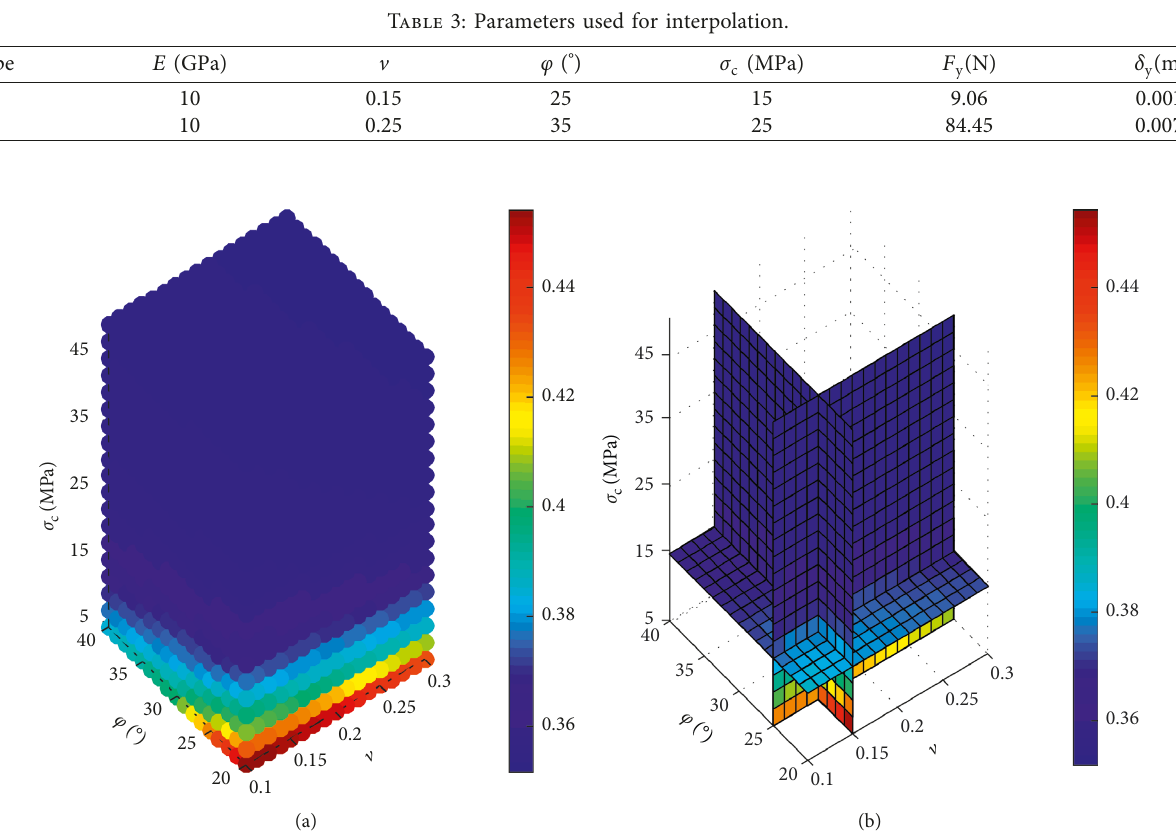
10 GPa. (a) Interpolated sample space; (b) the predicted value. (cid:31)